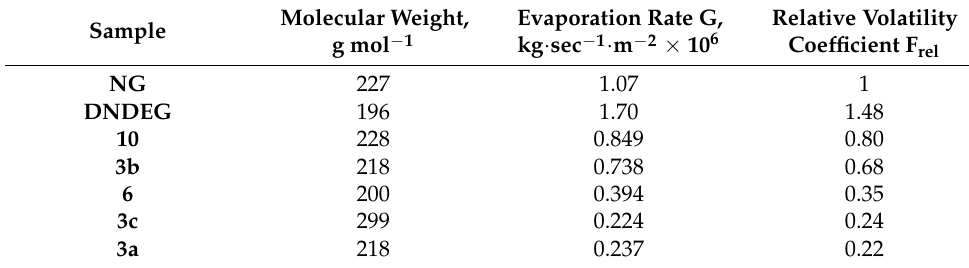
Table 3. Volatility of azides and nitro esters at 60 ◦